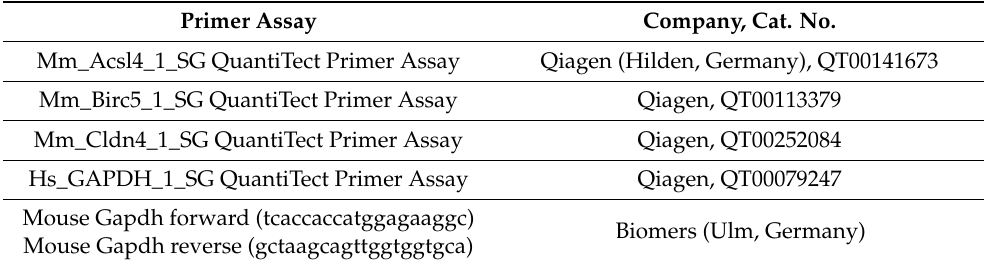
Table 1. Specific primer assays used for real-time PCR analysis. Primer